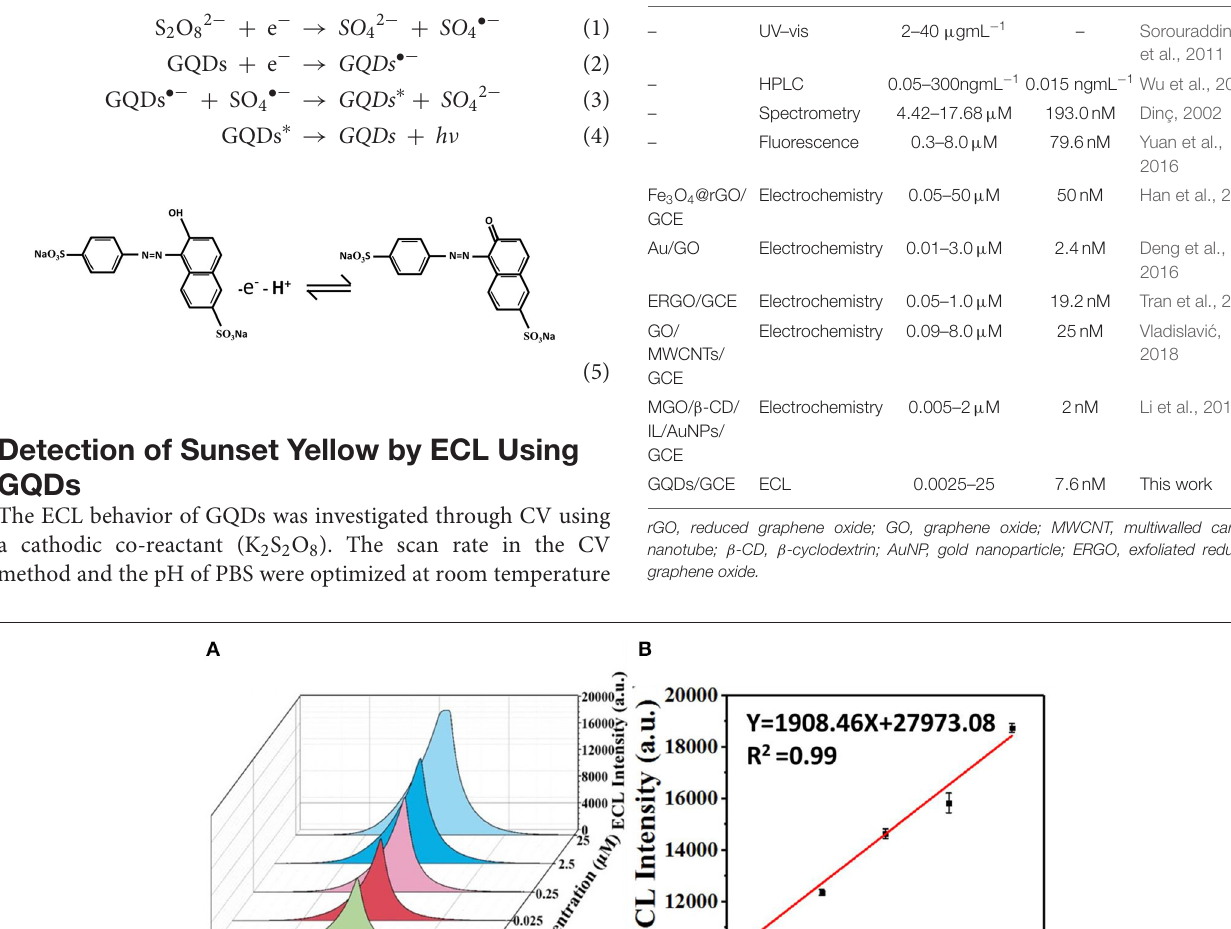
Frontiers in Chemistry |